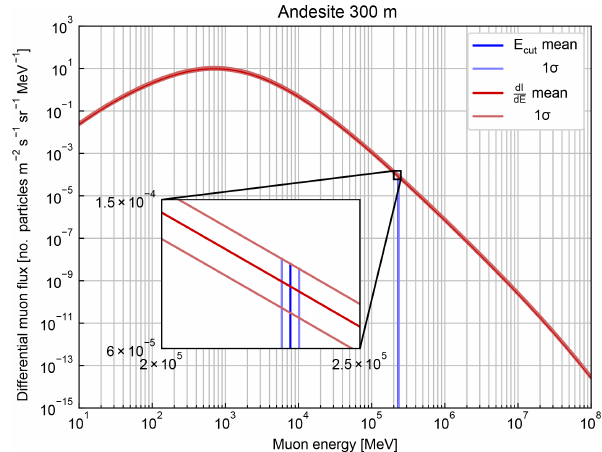
Figure C1. Differential muon flux as a function of muon kinetic energy. Blue lines indicate the simulated cut-off energy for 300m of andesite and its respective propagated error bounds. Red lines show the flux model and its 1 σ error